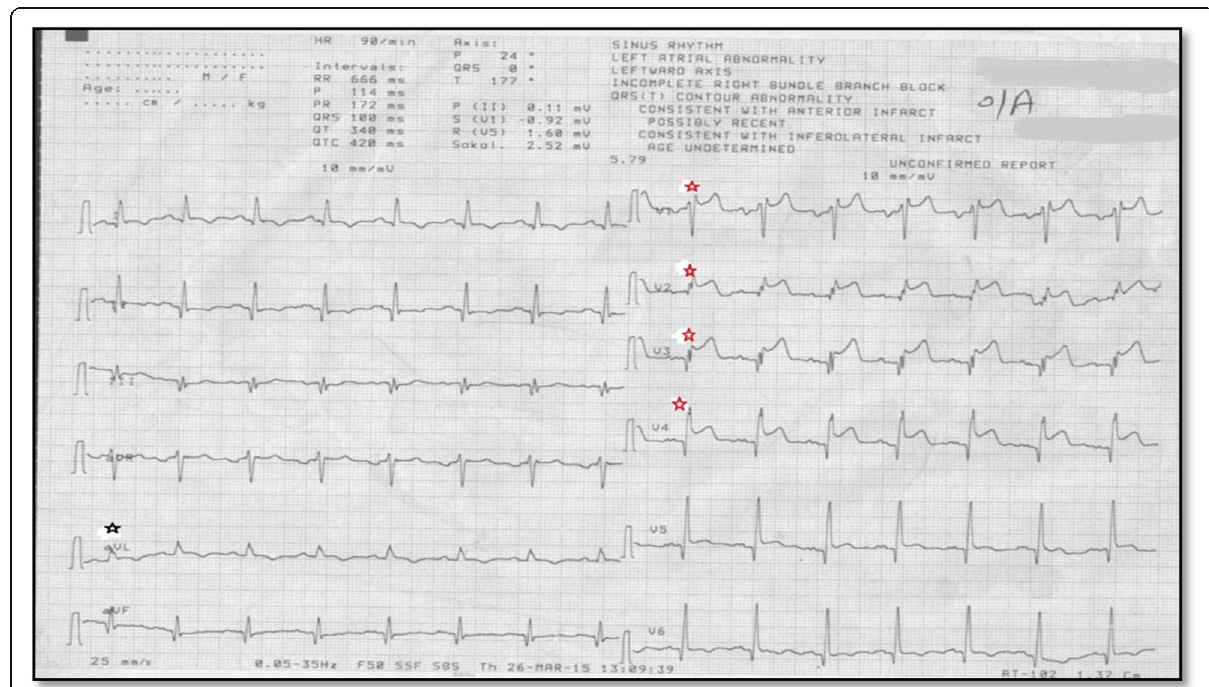
Fig. 1 f-QRS in V1-V4 (anterior f-QRS). Note that isolated f-QRS in aVL does not count as lateral